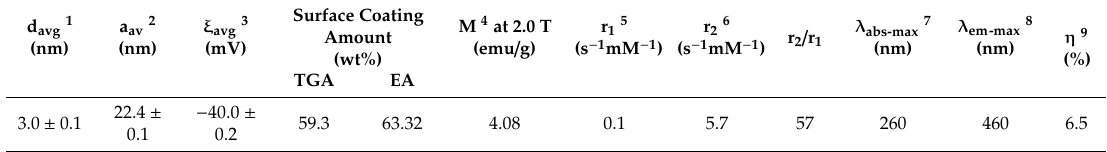
Table 1. Summarized properties of DYO@C nanoparticles.